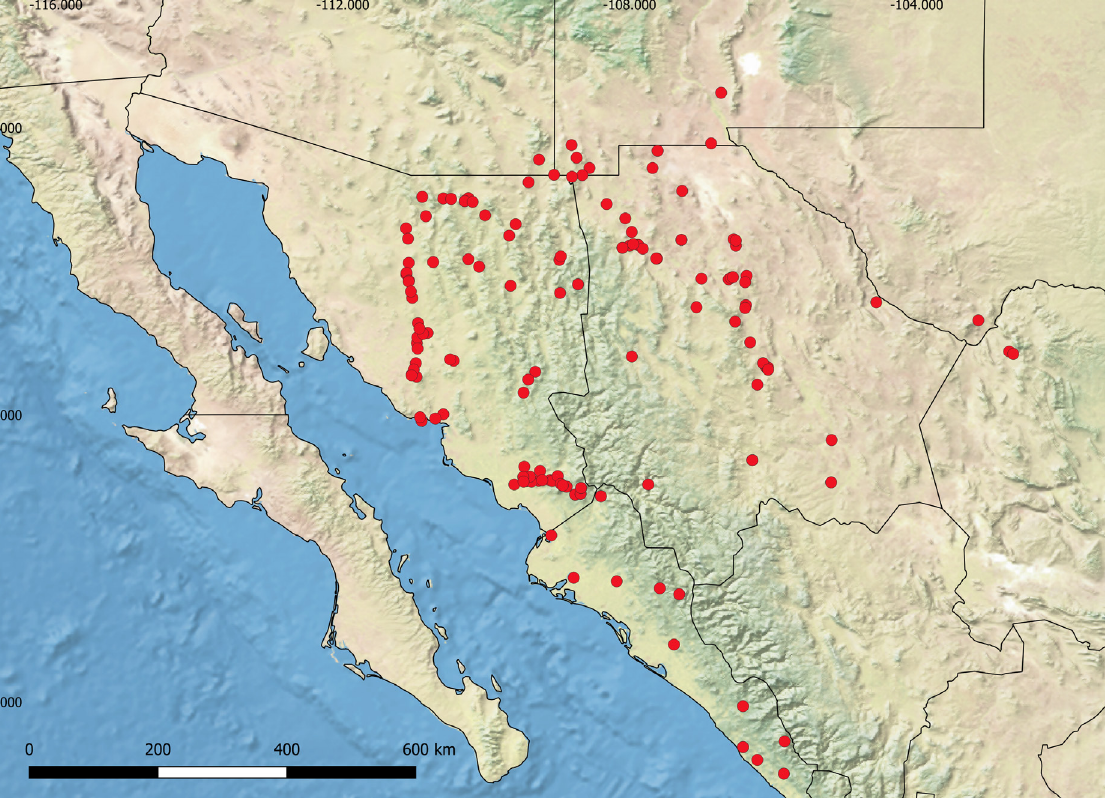
Fig. 6. Locality records of Salvadora deserticola Schmidt,